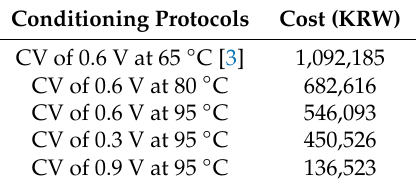
Table 4. International cost of hydrogen (per kg of hydrogen). Nation Cost